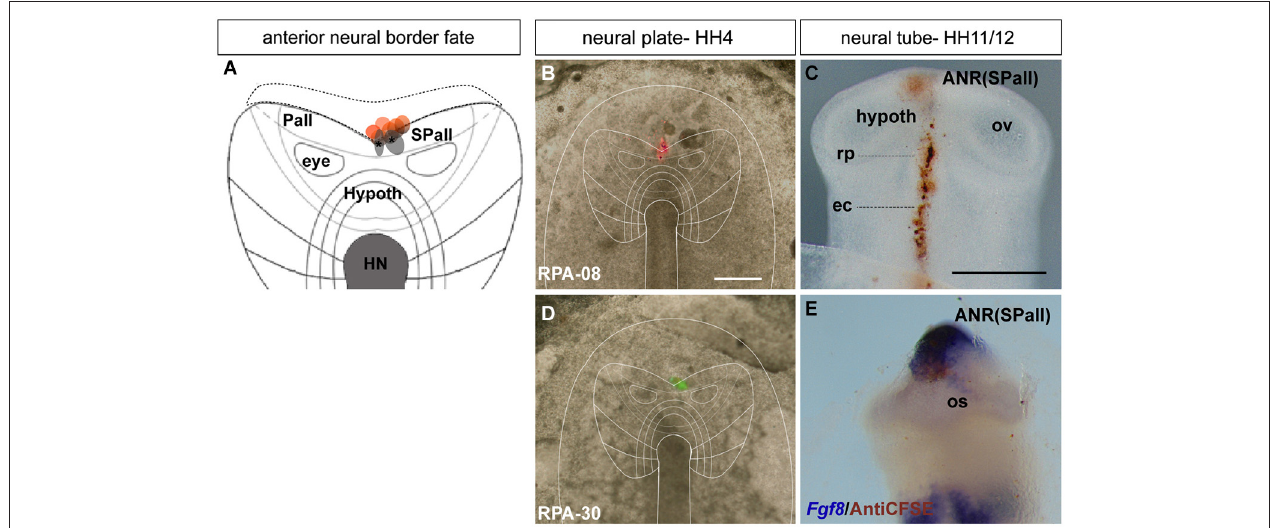
neural/non-neural midline, with part of the labeled cells within the telencephalic domain and another part extending into the prospective Rathke’s pouch and median head ectoderm approaching the anterior intestinal portal. The graft-derived cells largely were located at stage HH12 laterally at the prospective subpallium and ventrally at the prospective optic stalk. (E) In case RPA-30 some labeled cells overlap with Fgf8 expression in the neural and non-neural ectodermal cells. Scale bars: 250 µ